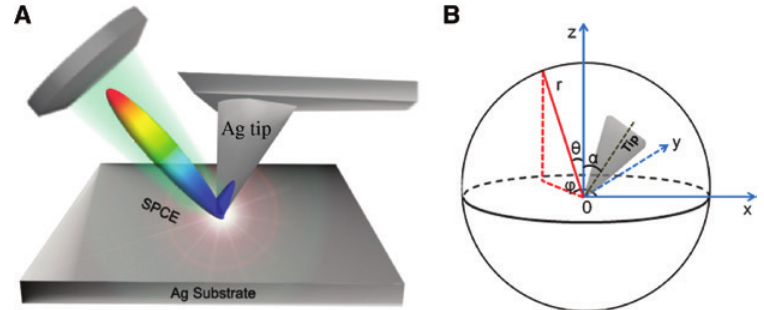
Figure 1: Calculation model. (A) The schematic of the tip-tilted side illumination-collection TES configuration. (B) The geometric angles under the spherical coordinate. The color image shows the highly directional TES